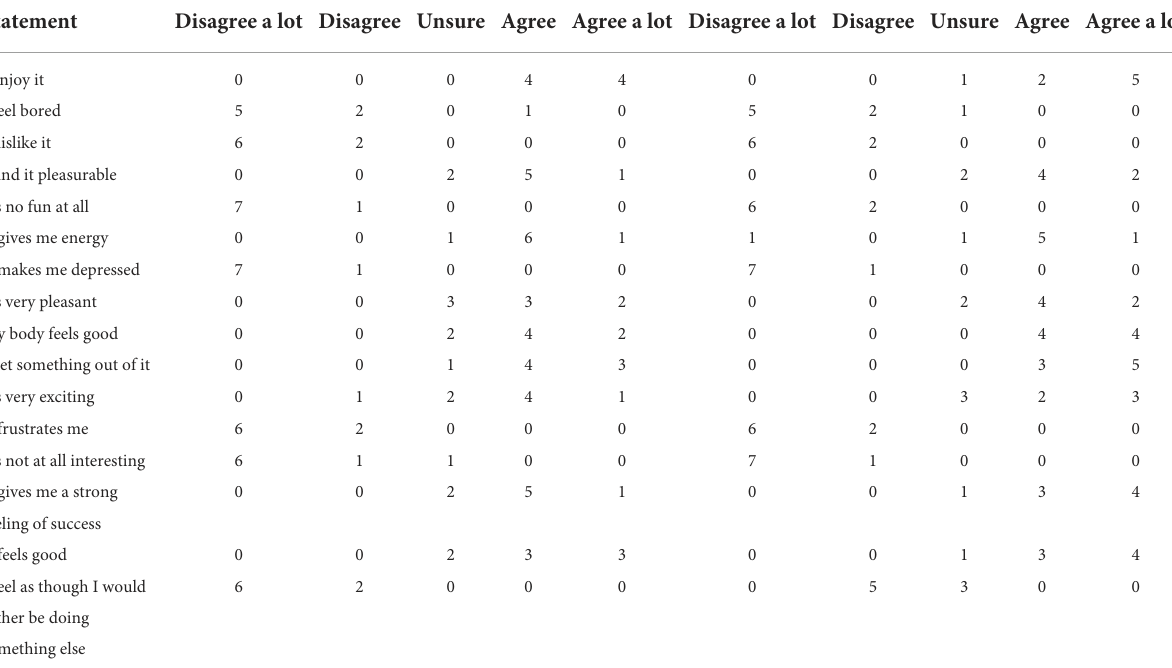
TABLE 3 Summary of the frequencies for individual statement responses of the PACES questionnaire ( n = 8 ). Session 1 response Session 4